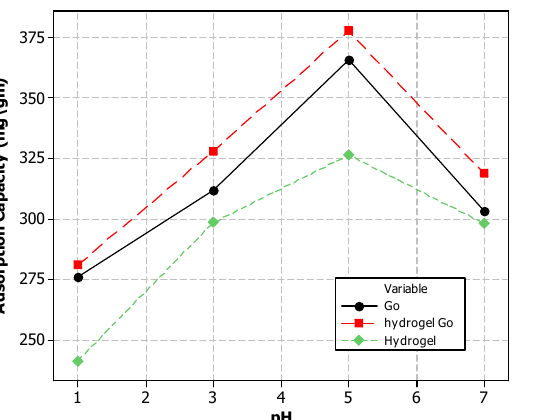
Fig. 7: Effect of contact time on adsorption of Cu(II) (initial Cu(II) mass concentration 500 mg l –1 , dosage of GO 100 mg l –1 , initial solution pH